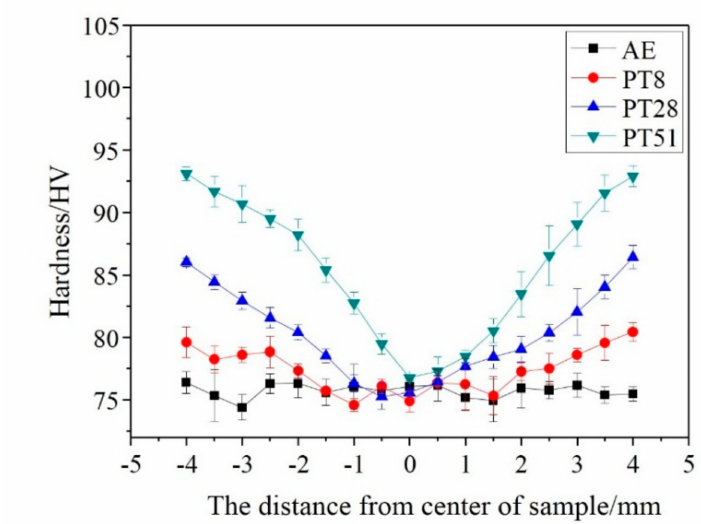
Figure 8. Vickers hardness variation along the radius of the twisted samples. Figure 9 shows the stress–strain curves of the alloy whose tensile and compression directions were parallel to the twist direction and the corresponding properties are sum- marized in Table 1. With the increase of strain, the tensile and compressive strength gradually improved. The tensile yield strength increased from 218 MPa to 241 MPa, and the compressive strength increased from 239 MPa to 259 MPa.